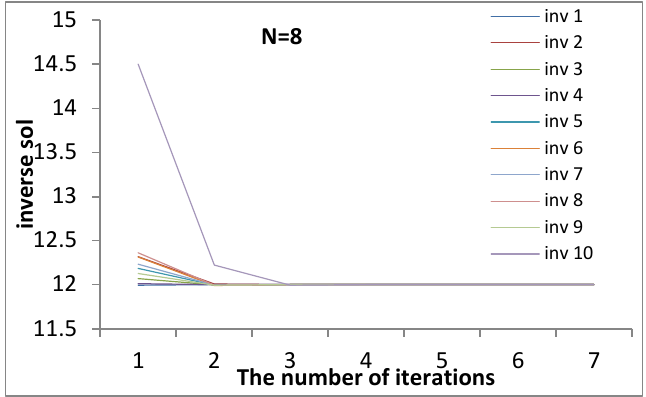
Figure 7. The inverse convergence curve of IABC colony, N = 8.